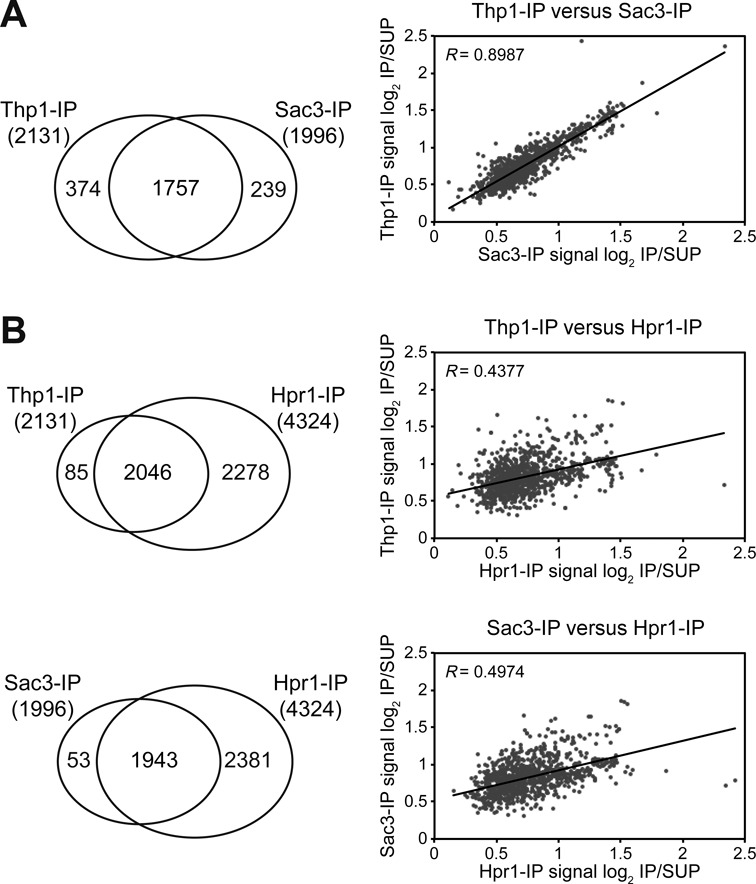
Analysis of Thp1- and Sac3-enriched genes compared to Hpr1. (A) Correlation between Thp1- and Sac3-enriched genes. Left, Venn diagram showing the overlap between Thp1- and Sac3-enriched genes in ChIP-chip analyses. Right, scatter plot showing correlation between Thp1 and Sac3 enrichment levels in the common ORFs. (B) Correlation among Thp1-, Sac3- and Hpr1-enriched genes. Left, Venn diagrams showing the overlap between Thp1-, Sac3- and Hpr1-enriched genes in ChIP-chip analyses. Right, scatter plots showing correlation between Thp1, Sac3 and Hpr1 enrichment levels in the common ORFs. A linear regression line and the Pearson's R correlation coefficient are plotted per scatter plot. The complete list of genes can be found in the Supplementary Dataset II.